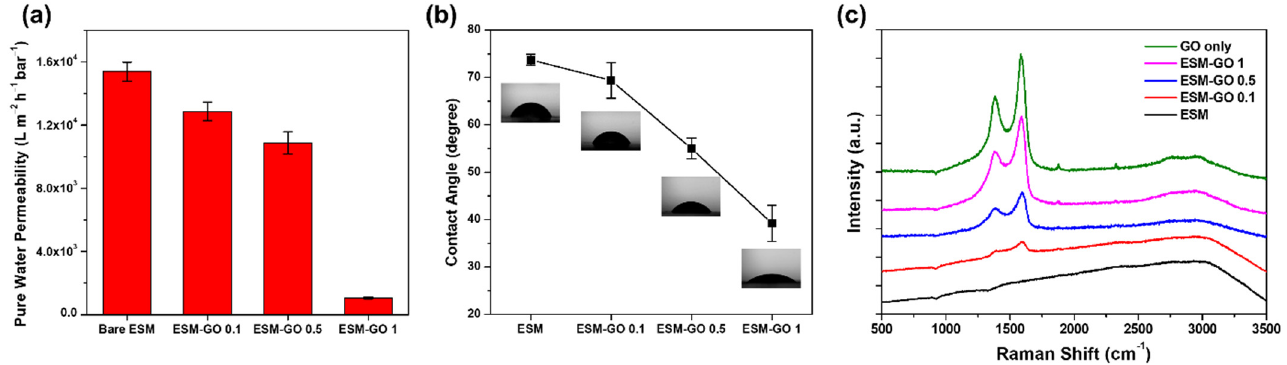
Figure 5. ( a ) Pure water permeability, ( b ) contact angle, and ( c ) Raman spectra of top surface of membrane.